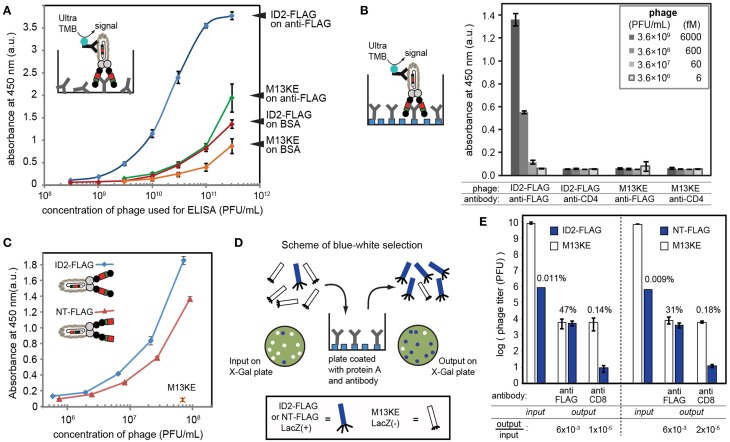
(A) The presence of inserted FLAG sequence can be validated by ELISA on wells coated by anti-FLAG antibody. Phage was detected using HRP-conjugated anti-M13 antibody and Ultra-TMB substrate for horseradish peroxidase (HRP). In control experiments, we coated wells with BSA or used M13KE phage without a FLAG insert. (B) ELISA signal in optimal conditions with oriented immobilization of anti-FLAG IgG on protein A-coated wells yielded signal detectible at 600 femtomolar concentration of phage (3.6 × 108 PFU/mL). In this experiment, we used wells coated by non-specific IgG (anti-CD4) as negative control. (C) Comparison of phage displaying FLAG at the N-terminus (NT) and in intra-domain (ID) fashion using setup analogous to (B). ID-display provides statistically significantly higher signal at equivalent titers. (D) Scheme of selection of ID-FLAG or NT-FLAG from a 1:10,000 mixture with insert-free phage. Enrichment is monitored as increase of blue (LacZ+) plaques on agar overlay containing X-gal. (E) Results of selection of ID-FLAG or NT-FLAG on wells presenting anti-FLAG or anti-CD8 (negative control). ID-display provides minor yet detectable advantage. Input to output ratios for insert-containing clones are displayed below the plot. In all experiments, data represents average from three to four independent wells; error bar is one standard deviation.